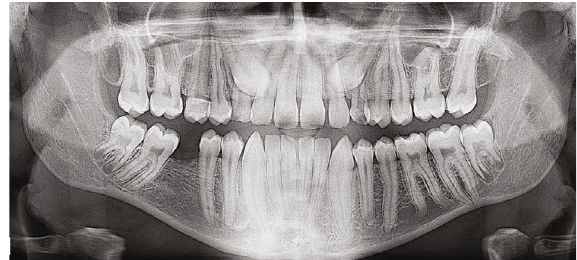
Figure 2: A panoramic radiograph showing the elongated roots of the